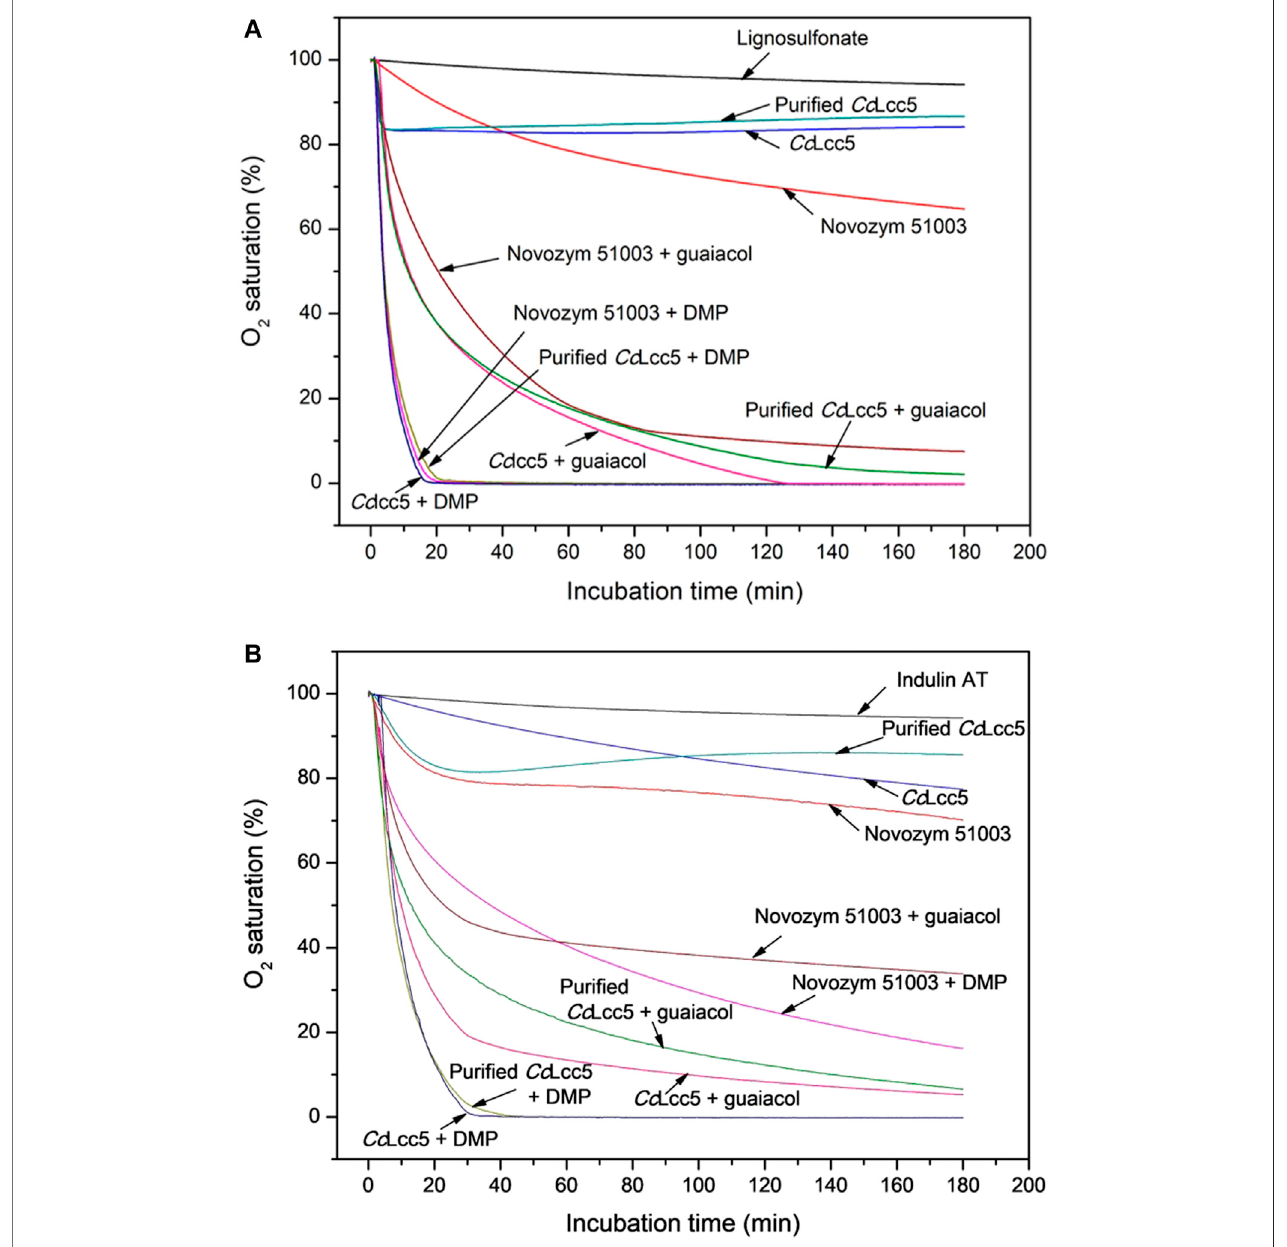
FIGURE 3 | Oxygen consumption curves in samples of technical lignins, (A) lignosulfonate and (B) Indulin AT, incubated without enzyme or with different laccase preparations, puri fi ed and unpuri fi ed Cc Lcc5 and Novozym 51003, in the absence or, in LLMS, in the presence of a mediator, either DMP or guaiacol. The curves are calculated as average values of three